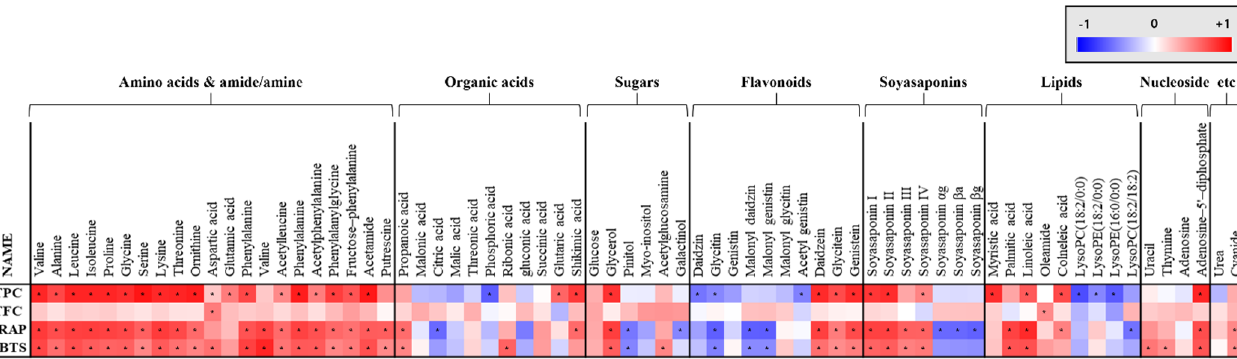
Figure 5. Heat map representation of correlation analysis between relative abundance of significantly discriminant metabolites and antioxidant activity (ABTS and FRAP), total flavonoid content (TFC), and total phenolic content (TPC). Each square indicates Pearson’s correlation coefficient values (r). Red and blue represent positive (0 < r < 1) and negative ( − 1 < r < 0) correlation, respectively. *; p -value less than 0.05, according to Duncan’s multiple range test.